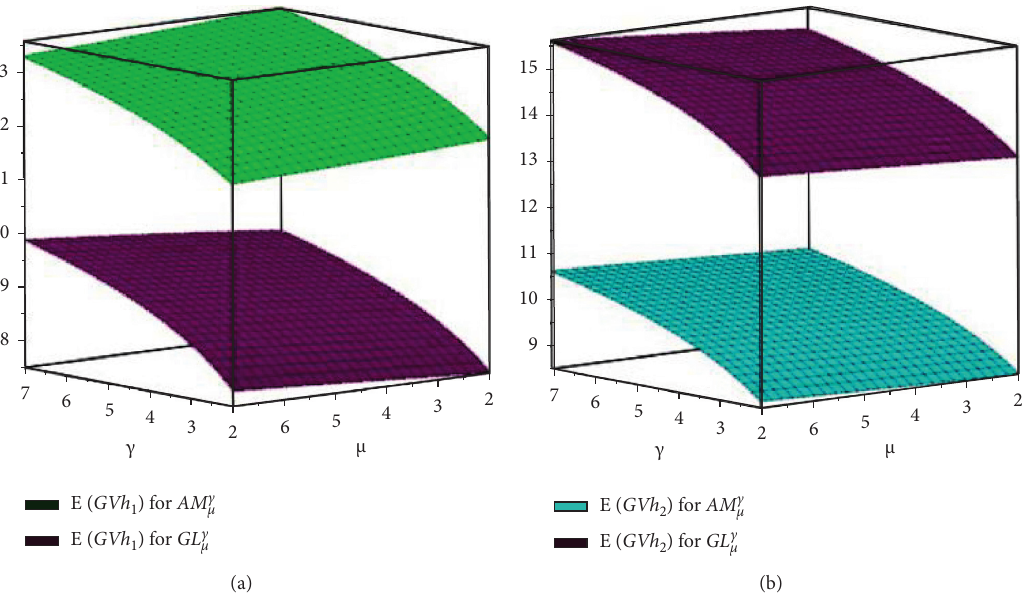
c μ and AM μ and (b) the second hyper Gourava